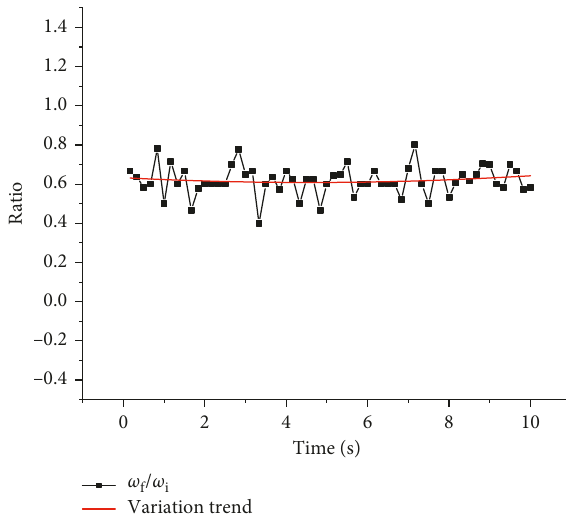
Figure 16: Specific angular speed value between the sleeve (with 6 rollers) and the shaft ( ω f / ω i ).